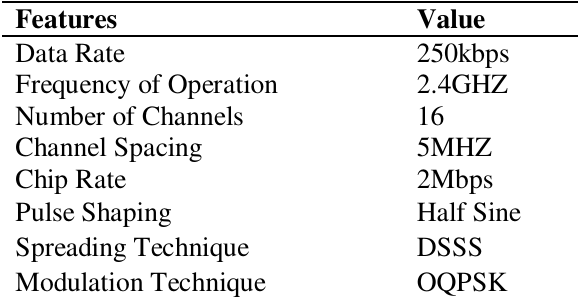
Specifications of 2.4 GHZ Zigbee Transmitter